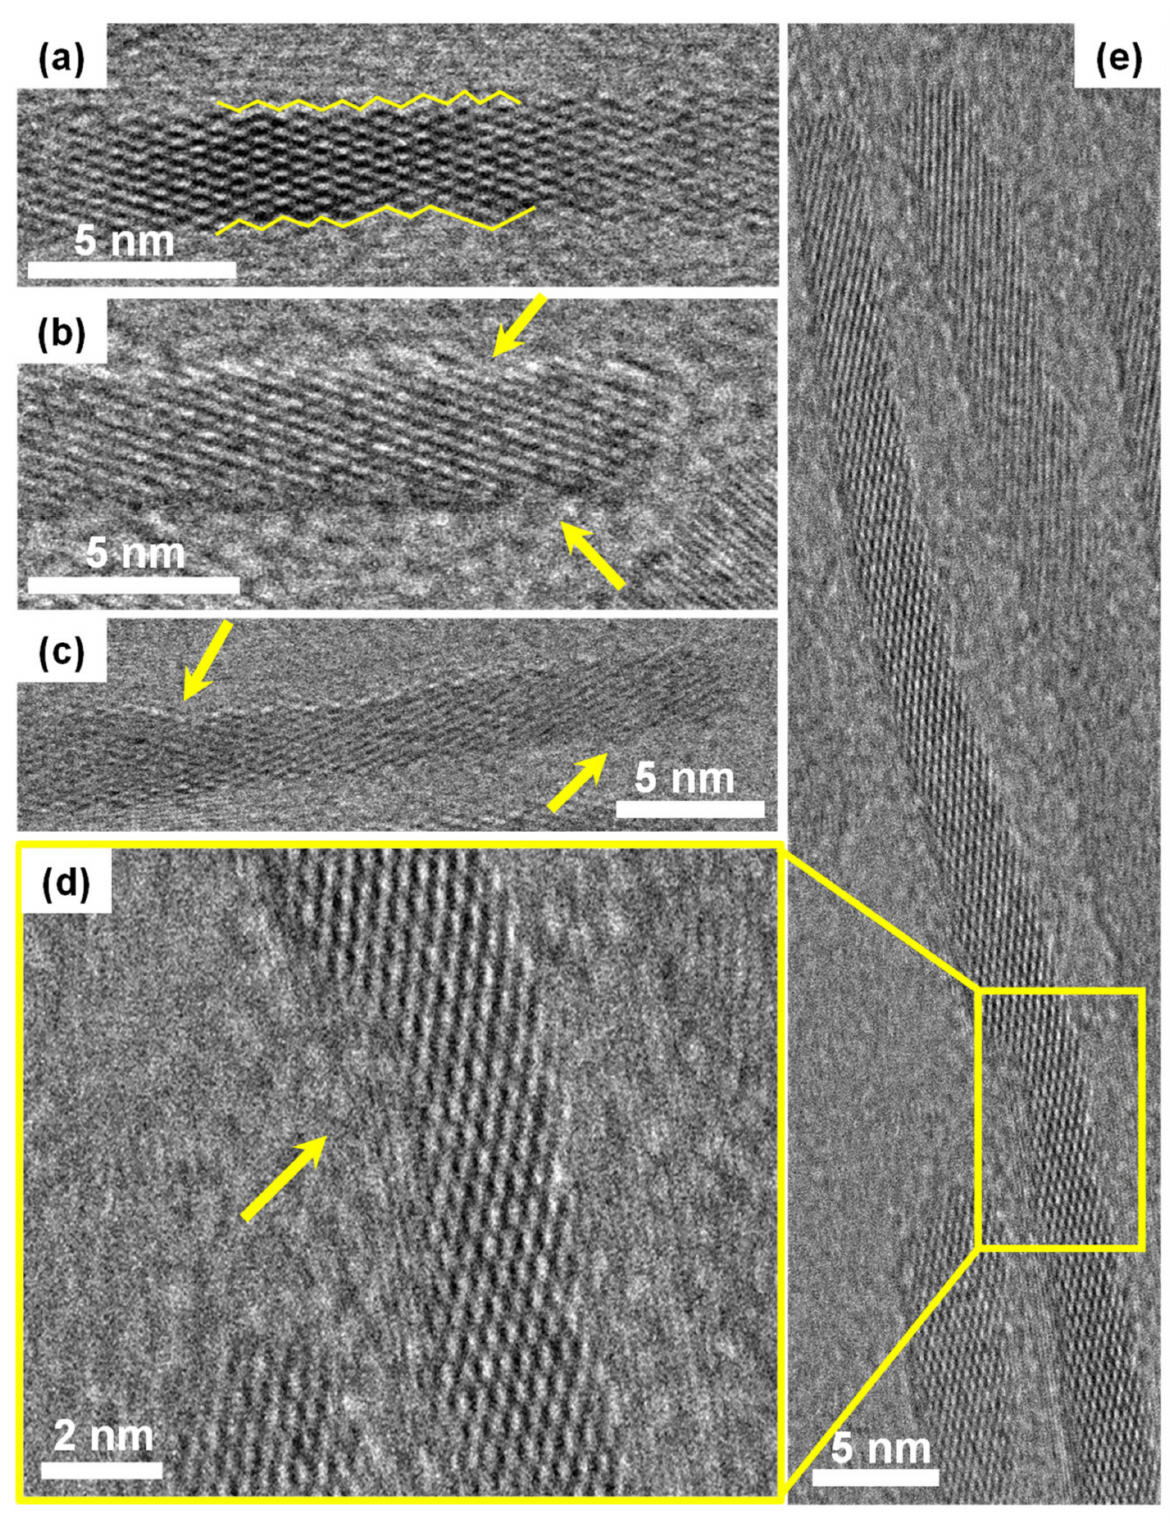
Figure 3. HRTEM micrographs of anatase NRs. ( a – e ) Surface features labeled by yellow arrows and lines on the surface of the NRs such as steps, corrugated sides, zigzag patterns, and sharp edges demonstrating give indications of the critical pinch points vulnerable to the